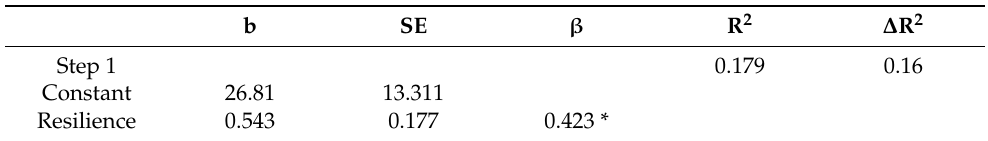
Table 8. Univariate linear regression analysis predicting posttraumatic growth from resilience for cadaveric donor